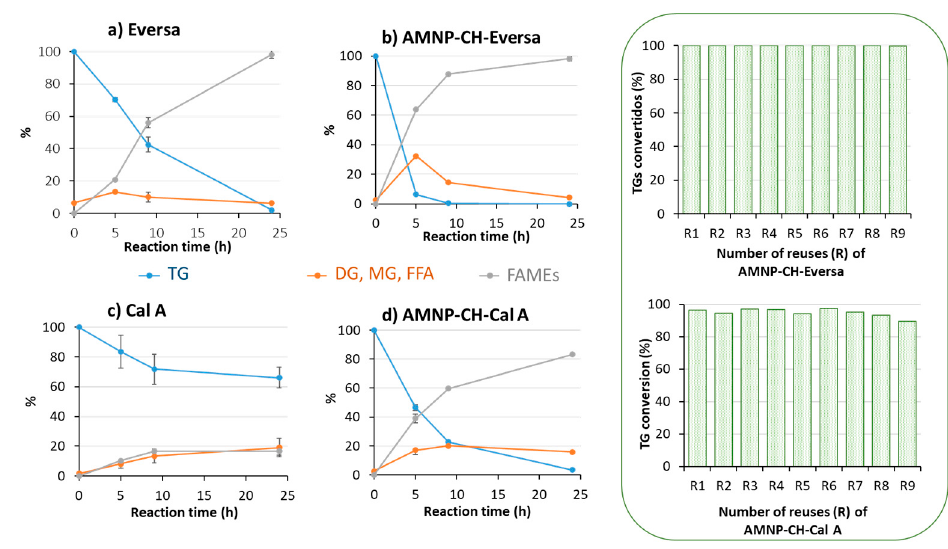
Figure 5. Enzymatic transesterification of discarded cooking oil and methanol catalyzed by: ( a ) soluble Eversa; ( b ) AMNP-CH-Eversa; ( c ) soluble Cal A; and ( d ) AMNP-CH-Cal A. The bar plots framed in green represent the operational stability of the immobilized enzymes in nine consecutive 24 h transesterification cycles. The reactions were developed over 24 h at 25 °C, with a rotational stirring (100 rpm), an oil:methanol ratio of 1:4, and 100 mg of each nanobiocatalyst. TGs: Triglycerides; DGs: Diglycerides; MGs: Monoglycerides; FFAs: Fatty acids; FAMEs: Methyl esters.